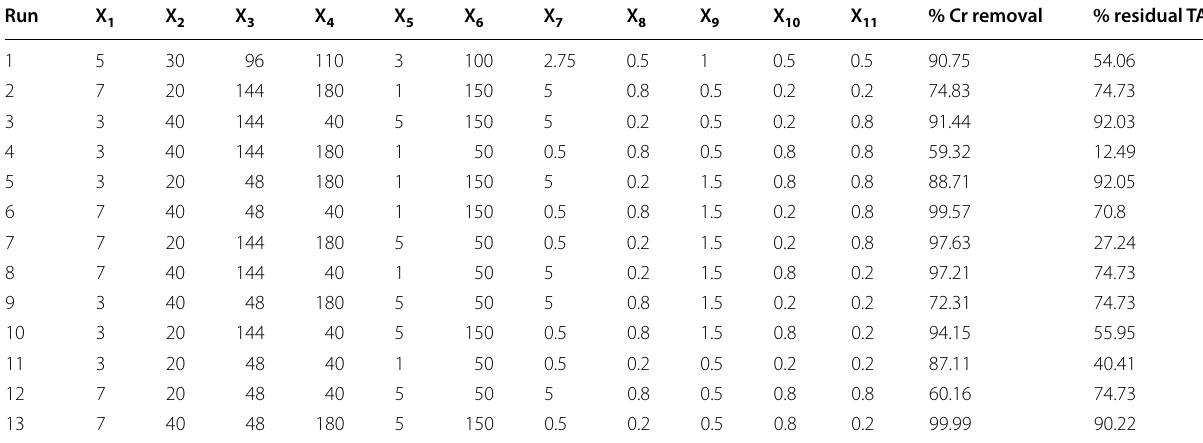
Table 1 Plackett Burman experimental design matrix of eleven